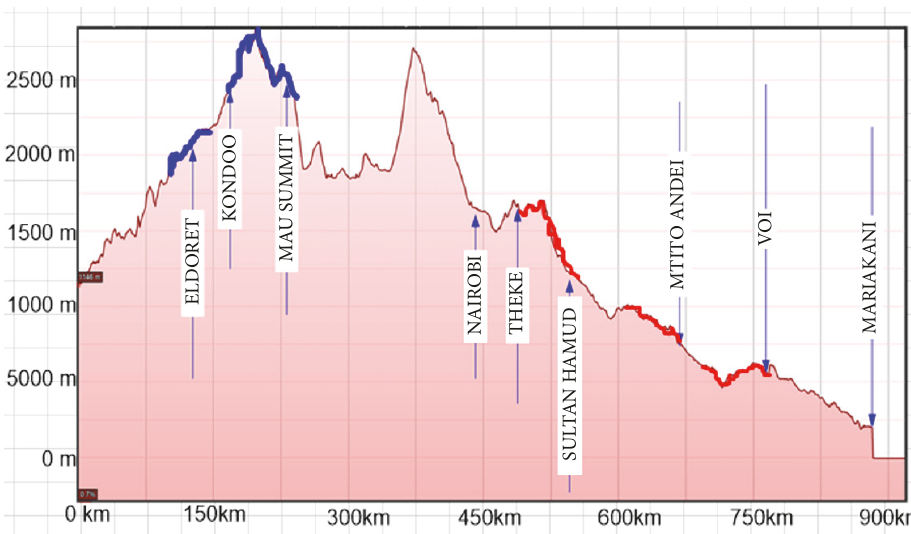
Figure 1: 900 km cross section from Kenya’s sea level (coast) to rift valley highlands through northern lowlands. Vertical plane represents fibre route altitude while horizontal plane represents fibre length.